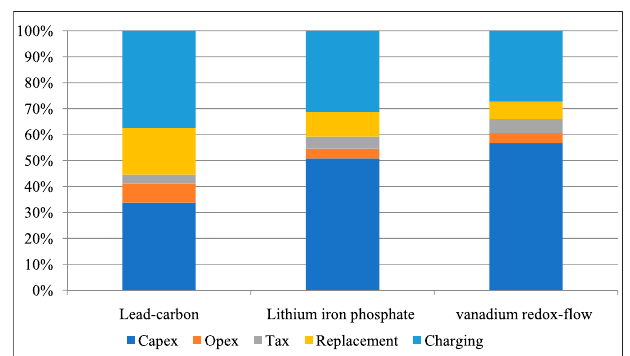
FIGURE 9 | Cost breakdown of the three different types of battery technologies in EES